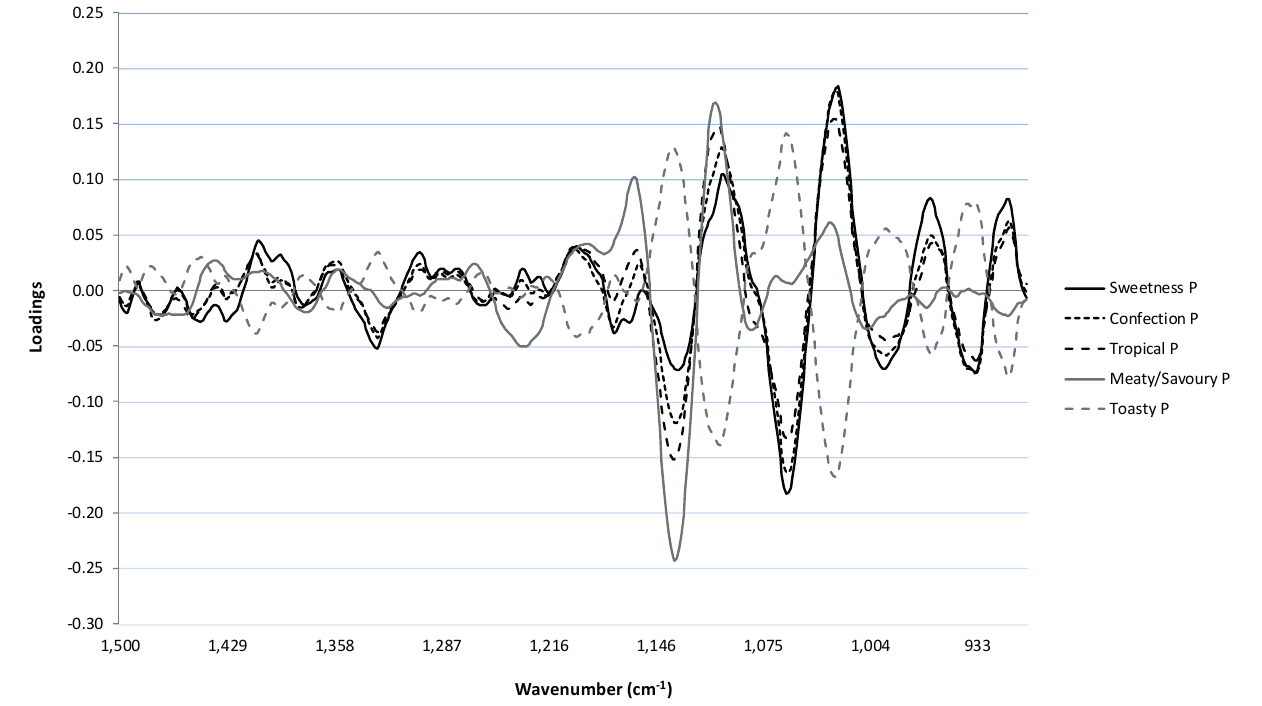
Figure 5. Optimal partial least squares regression coefficients derived from analysis of the MIR fingerprint spectra (1500–900 cm − 1 ) against the top five correlated sensory attributes ( sweetness P , confection P , tropical P , meaty/savoury P and toasty P ) for the sparkling white wines. P denotes that the sensory attribute was rated on the